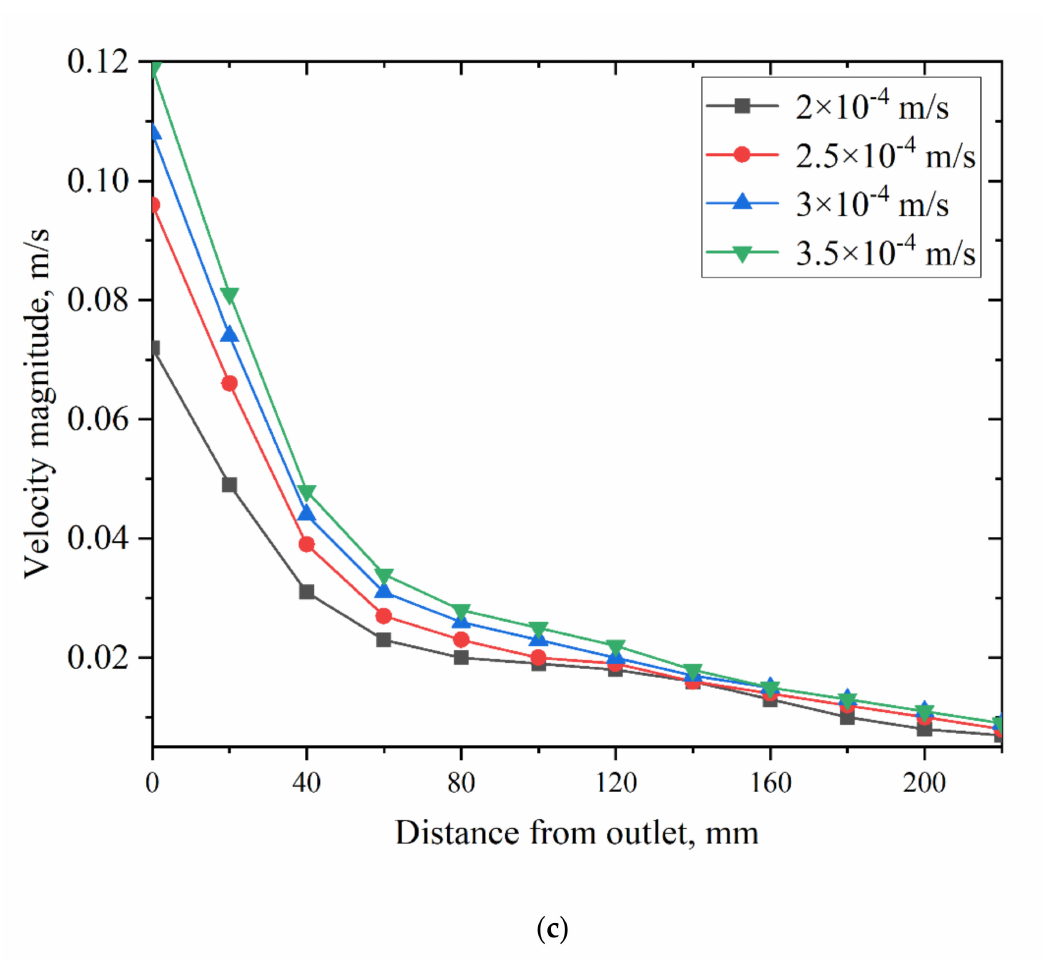
Figure 4. ( a ) Contours of the velocity magnitude at casting velocities of (a) 2 × 10 − 4 , (b) 2.5 × 10 − 4 , (c) 3 × 10 − 4 , and (d) 3.5 × 10 − 4 m/s with a pouring temperature of 2273 K. ( b ) The sampling points at the symcenter on the contour of the velocity magnitude. ( c ) Velocity magnitudes of sampling points at casting velocities of 2 × 10 − 4 , 2.5 × 10 − 4 , 3 × 10 − 4 , and 3.5 × 10 − 4 m/s with a pouring temperature of 2273